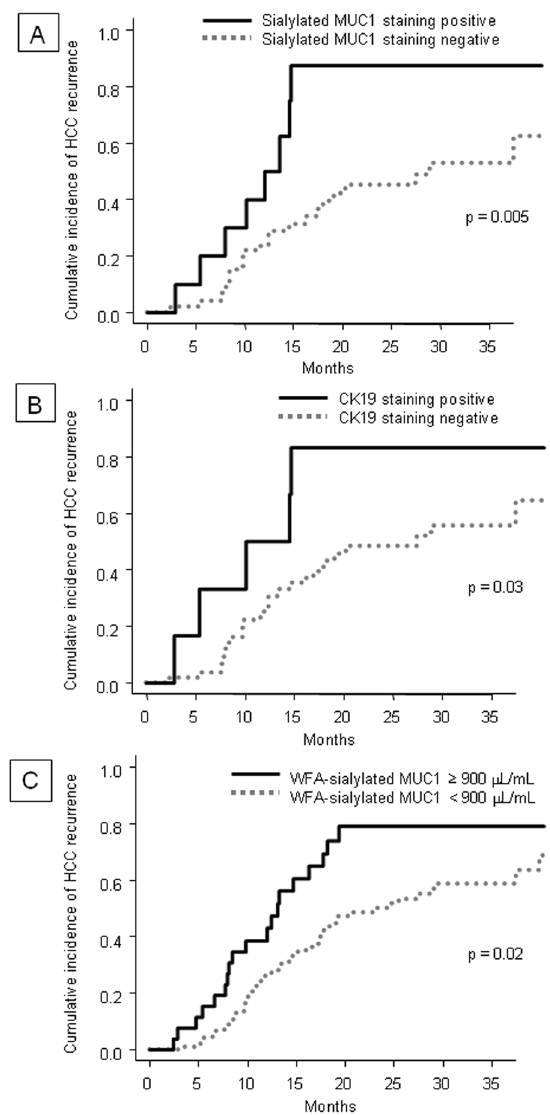
Figure 5. Cumulative incidence of HCC recurrence. Patients were categorized into two groups according to ( A ) sialylated MUC1 staining, ( B ) CK19 staining and ( C ) serum WFA-sialylated